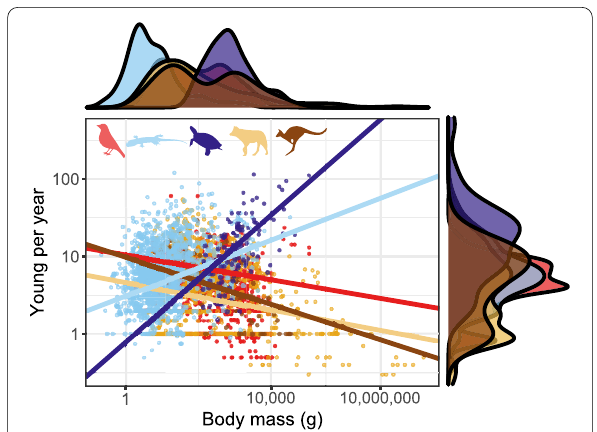
Fig. 12 Allometry of young per year. Red: birds; blue: squamates; purple: turtles; yellow: placental mammals; brown: marsupial mammals. Solid lines are regression slopes from PGLS analyses. Note that both the axes are log 10 scaled